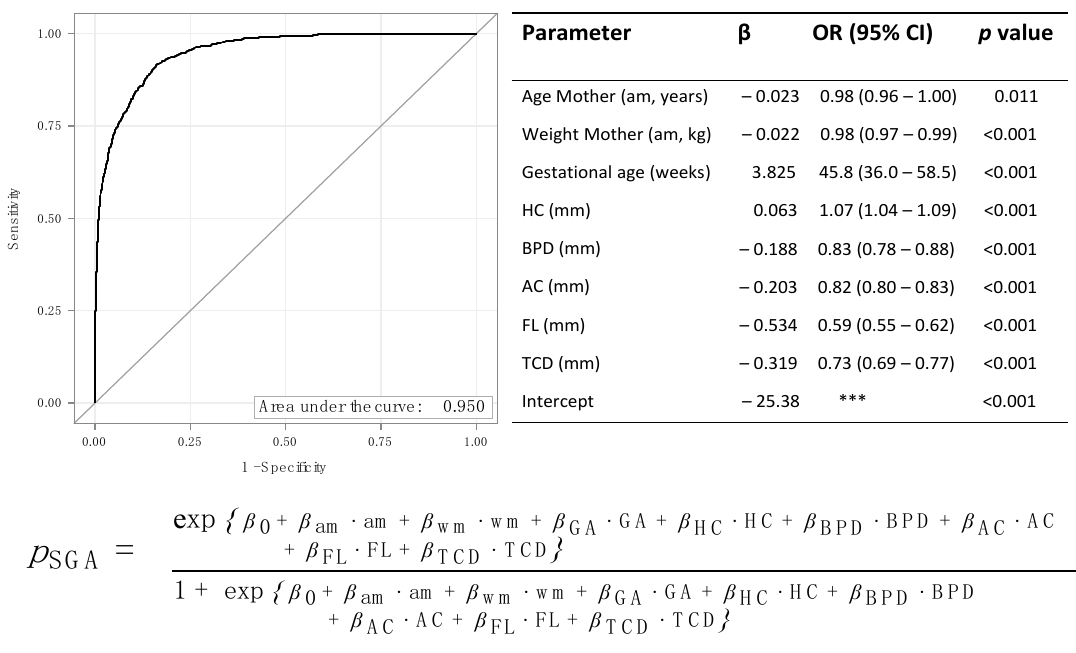
Figure 4. Multivariable regression: Prediction of SGA. AC = abdominal circumference, BPD = biparietal diameter, ß = regression coefficient, CI = confidence interval, FL = femur length, HC = head circumference, SGA = small for gestational age, OR = odds ratio, TCD = transcerebellar diameter. *** CI not given